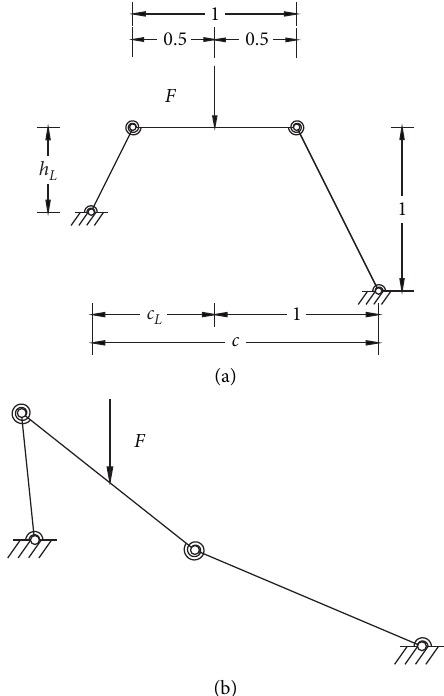
Figure 11: (a) The geometry of the asymmetric portal frame adopted in the FE analysis (with h R � 1, e � 0, and c L /h L � c R /h R ) and (b) a typical deformed shape of the portal frame under loading.